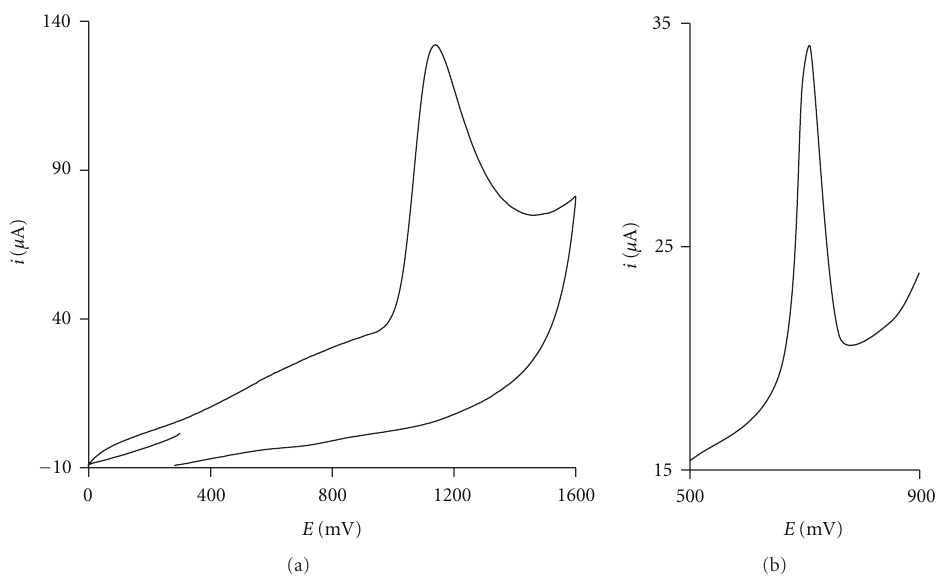
Figure 5: (a) Cyclic voltammogram of ASA at pH 1.0 on RF/GCE; scan rate 100mVs − 1 (b) SWSV of ASA on RF/GCE under optimum conditions.